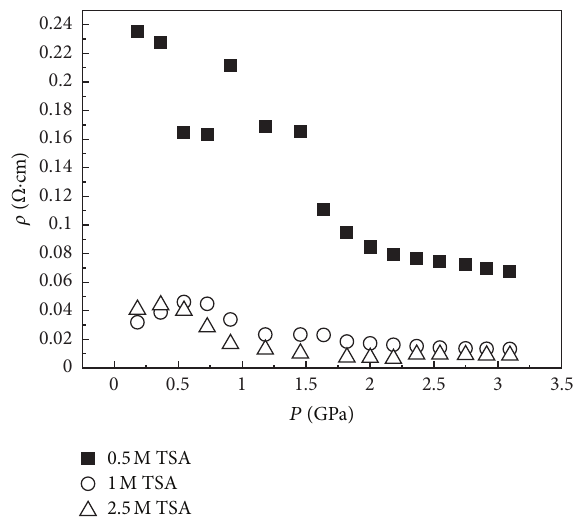
Figure 5: Effect of concentrations of TSA on resistivity of PAN under high pressure.